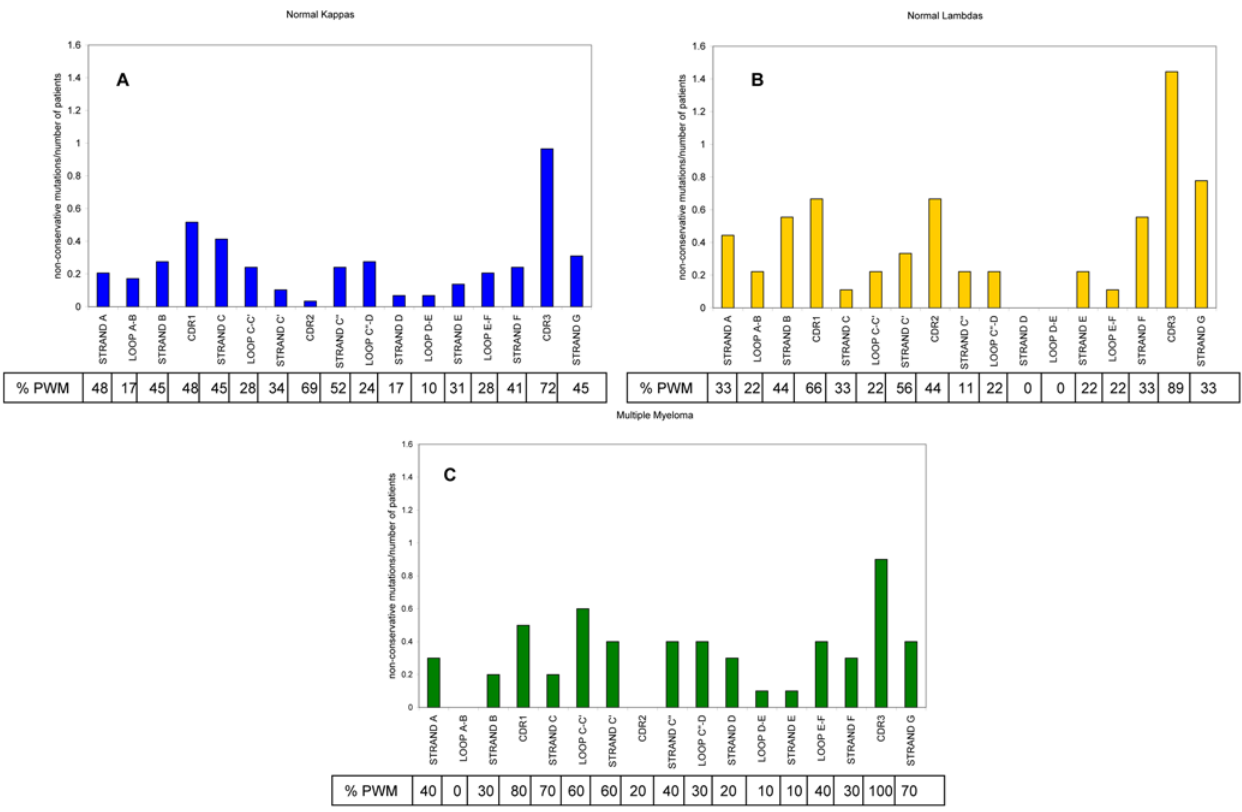
Figure 3. Non-conservative mutations over total number of patients for each secondary structure element for normal control V l , V k , and multiple myeloma control proteins. The x-axis shows the different elements of secondary structure in the VL, while the y-axis gives the ratio of non-conservative mutations in each secondary structure element per total number of sequences. The secondary structure boundaries used were based on the germline donor for each protein. Numbering is based on Kabat (http://vbase.mrc-cpe.cam.ac.uk/). A) V k normal control sequences. B) V l normal control sequences. C) Multiple Myeloma control sequences (combined V l and V k ). The percentage of sequences with mutations (% PWM) in each secondary structure element is listed per